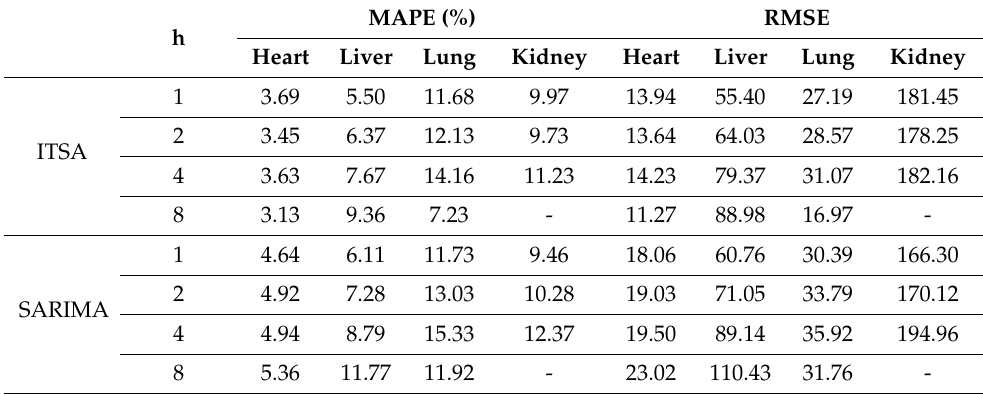
Table 3. Forecast accuracy measures by organ type at various forecast